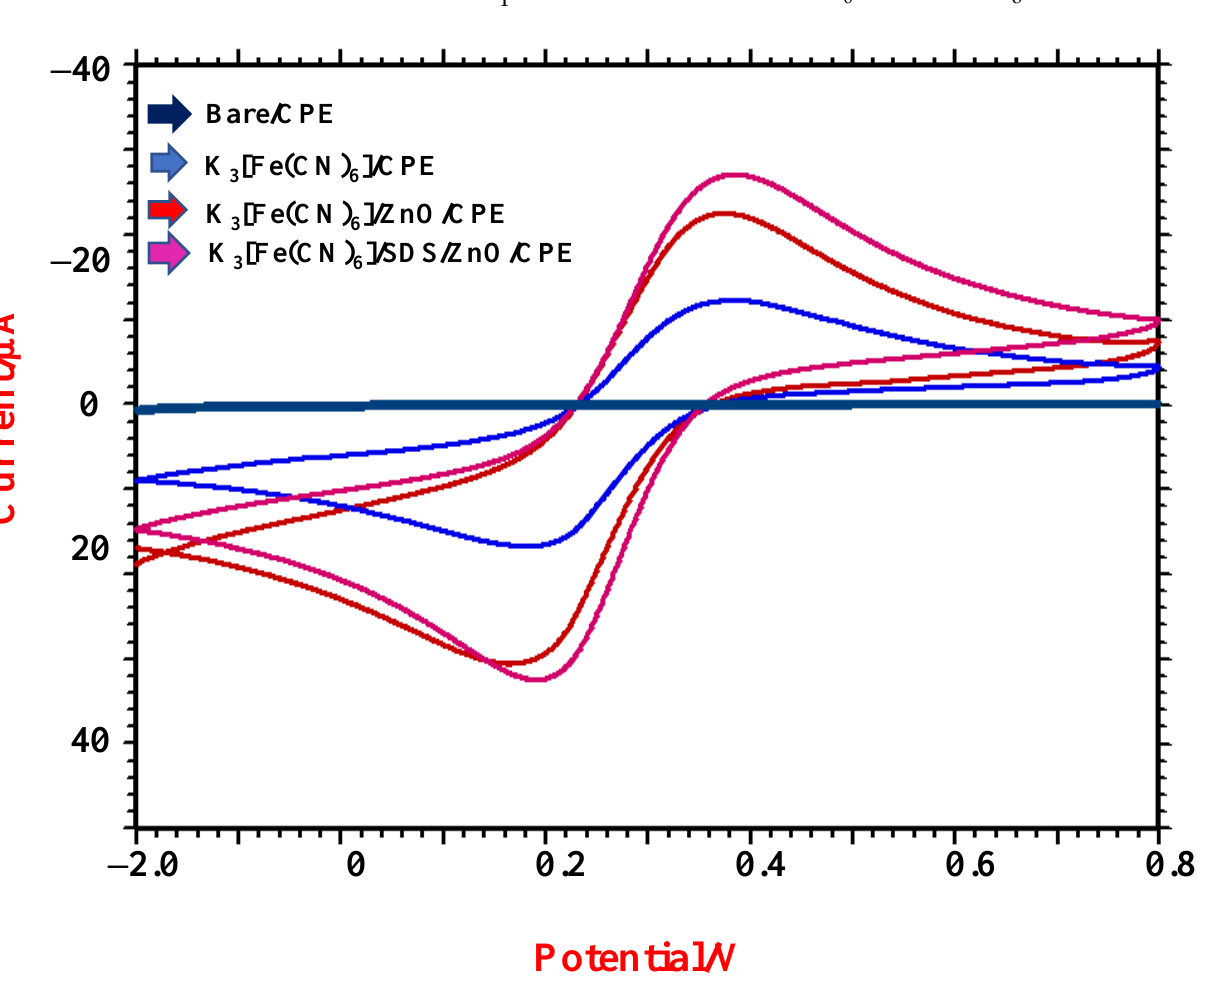
Figure 1. CV measurements of 1.0 mM K 3 (Fe (CN)6) at bare CPE and ZnO/CPE and ZnO/SDS/CPE.